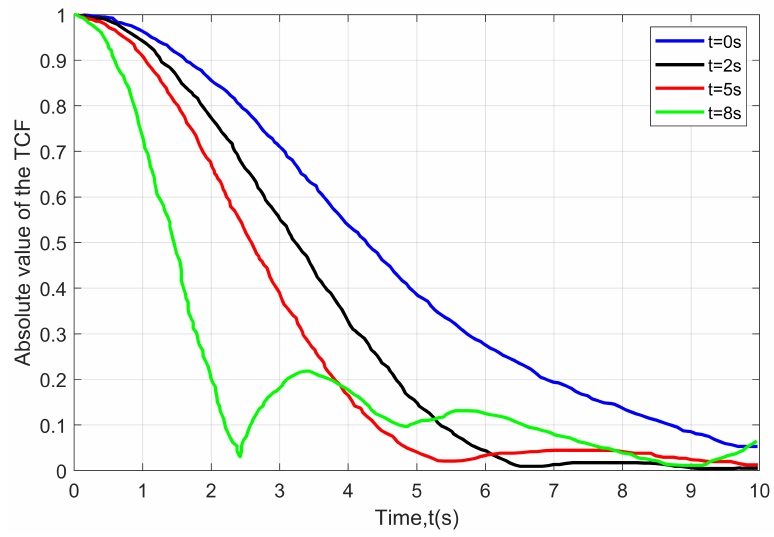
Figure 3. The absolute TCFs at any time instant t ( s ) .